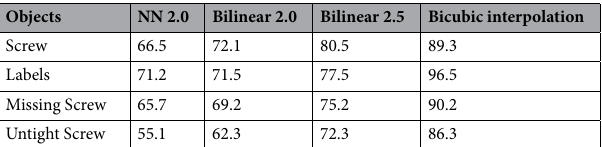
Table 5. Comparison of Interpolation methods on proposed model